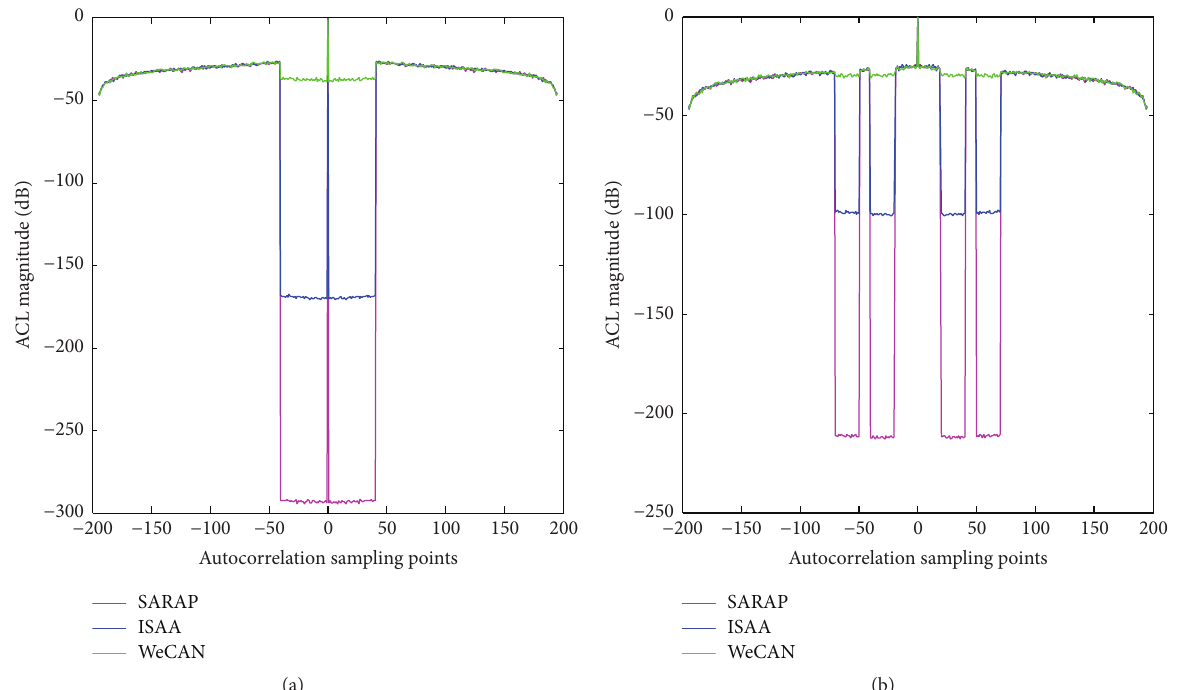
= [1 : 40] ; (b) illustrates the case 𝑄 1